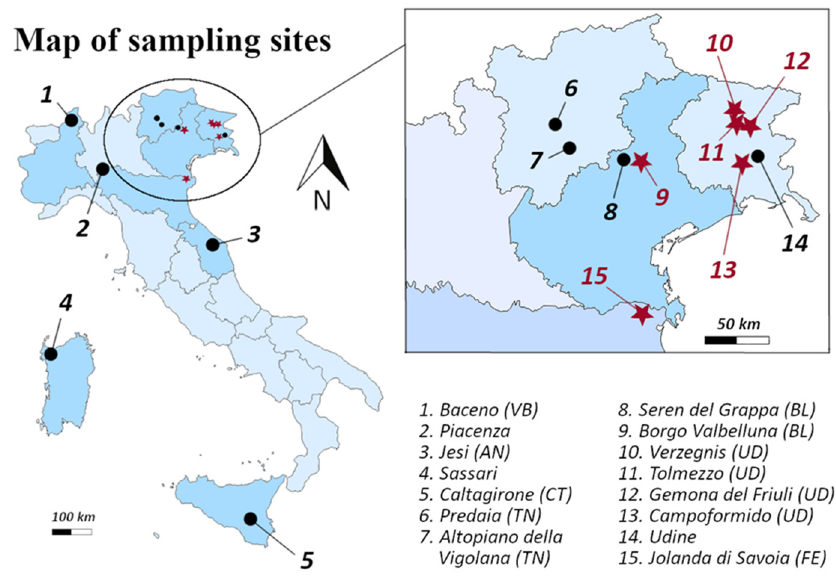
Figure 1. Map of the 2018 (red stars) and 2019 (black circles) sampling sites.